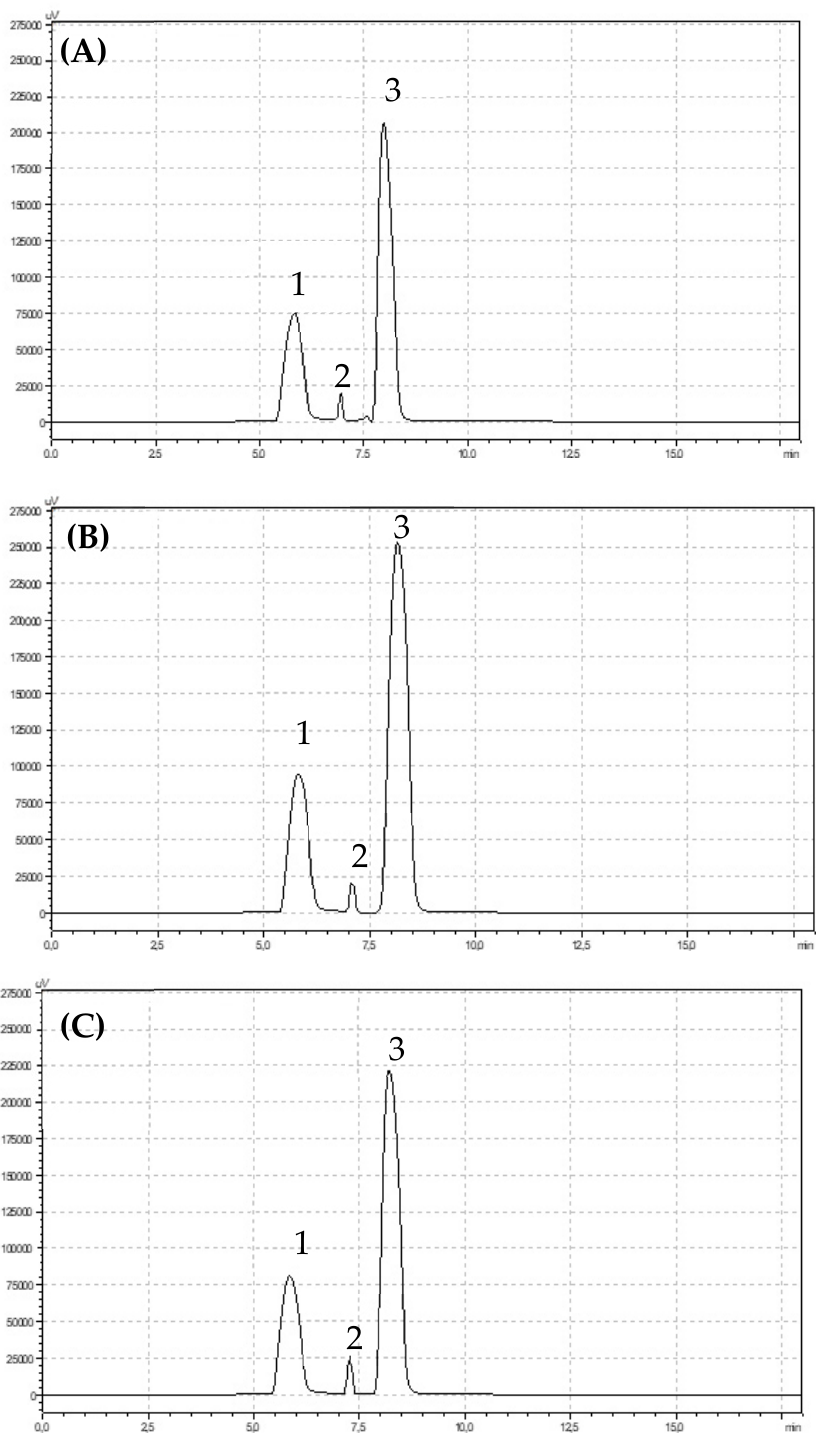
Figure 4. Chromatograms showing retention times for anthocyanins identified in ( A ) organic ( B ) integrated and ( C ) conventional strawberries (1) pelargonidin-3-O-glucoside, (2) pelargonidin-3-O-rutinoside, (3) cyanidin-3-O-glucoside,.